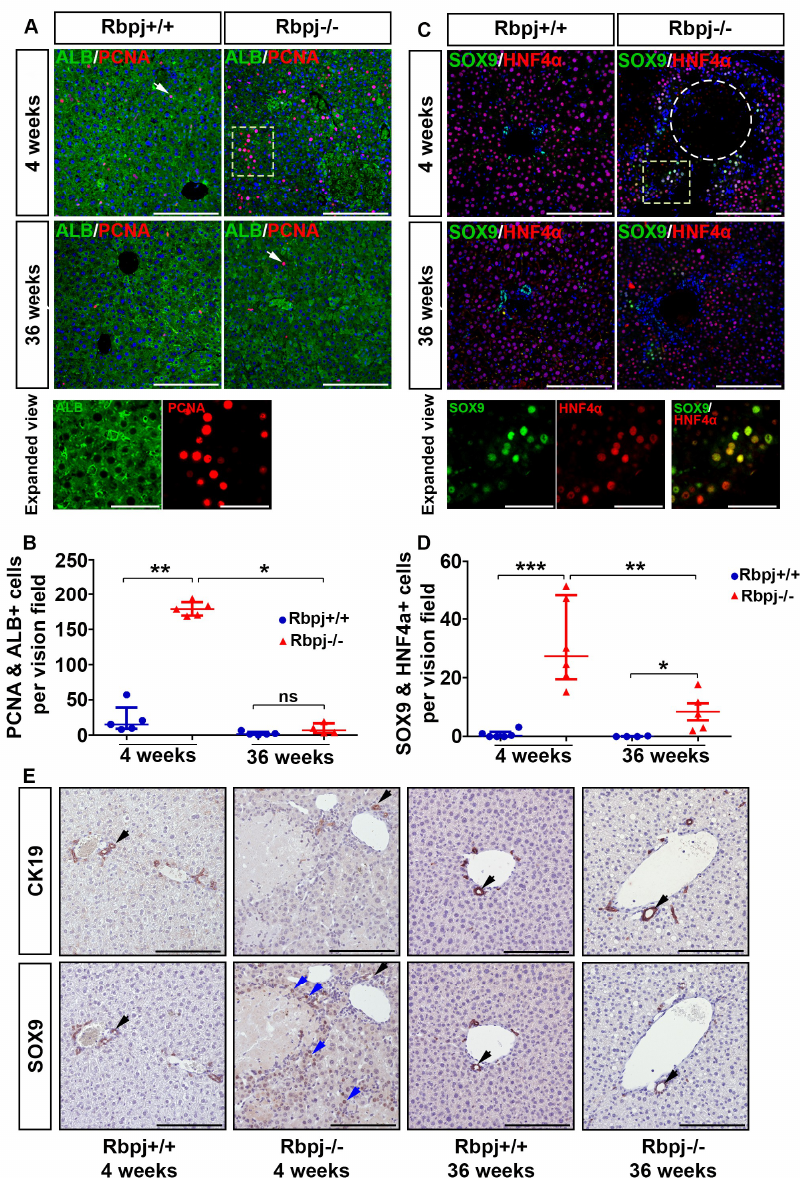
Figure 4. Regenerative proliferation upon RBPJ deficiency induced cholestasis. ( A ) Representative photographs of co-immunostaining of hepatocyte specific marker albumin (green), proliferation marker PCNA (red) and DAPI (blue) of Rbpj +/+ and Rbpj −/− liver at the age of 4 and 36 weeks (white arrows indicating proliferating hepatocytes in 4 week Rbpj +/+ and 36 week Rbpj −/− liver). Four-week-old Rbpj −/− liver show an increase in PCNA + hepatocytes, which does not persist at 36 weeks ( n = 5; scale bar: 100 µm). The white dotted area of the 4-week-old Rbpj −/− liver is shown as an expanded view (scale bar: 25 µ m). ( B ) Scatter dot plots of PCNA and albumin double positive cells ( n = 5; ** p ≤ 0.01, * p ≤ 0.05, ns = not significant; Mann–Whitney test (Two tailed). ( C ) Representative photographs of co-immunostaining for the hepatic progenitor/cholangiocytic marker SOX9 (green), hepatocyte marker HNF4 α (red) and DAPI (blue) ( n = 5). SOX9 positive hepatocytes surrounding necrotic area indicating induced hepatocyte plasticity upon Rbpj deletion induced cholestasis ( n = 5; scale bar: 100 µ m). The dotted circle represents necrotic area. The marked area of the 4-week-old Rbpj − / − liver is shown as an expanded view (scale bar: 25 µ m). ( D ) Quantification of SOX9 and HNF4 α double positive cells in liver from 4 and 36 weeks Rbpj +/+ and Rbpj − / − mice ( n = 5; *** p ≤ 0.001, ** p ≤ 0.01, * p ≤ 0.05, Mann–Whitney test (Two tailed)). ( E ) Representative photographs of CK19 and SOX9 immunostaining performed on serial sections ( n = 5; scale bar: 100 µ m). CK19/SOX9 double positive cells (brown staining) are depicted by black arrows, SOX9 single positive cells by blue arrows. SOX9 single positive cells are enriched surrounding the necrotic area (sections are counterstained with hematoxylin which arises as blue stained